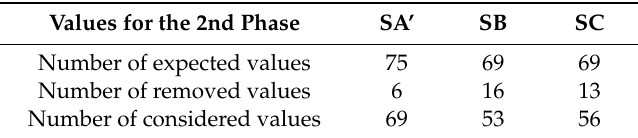
Table 2. Numbers of expected, removed and considered values for the data curation and statistical analysis of the secondphase. Values for the 2nd Phase